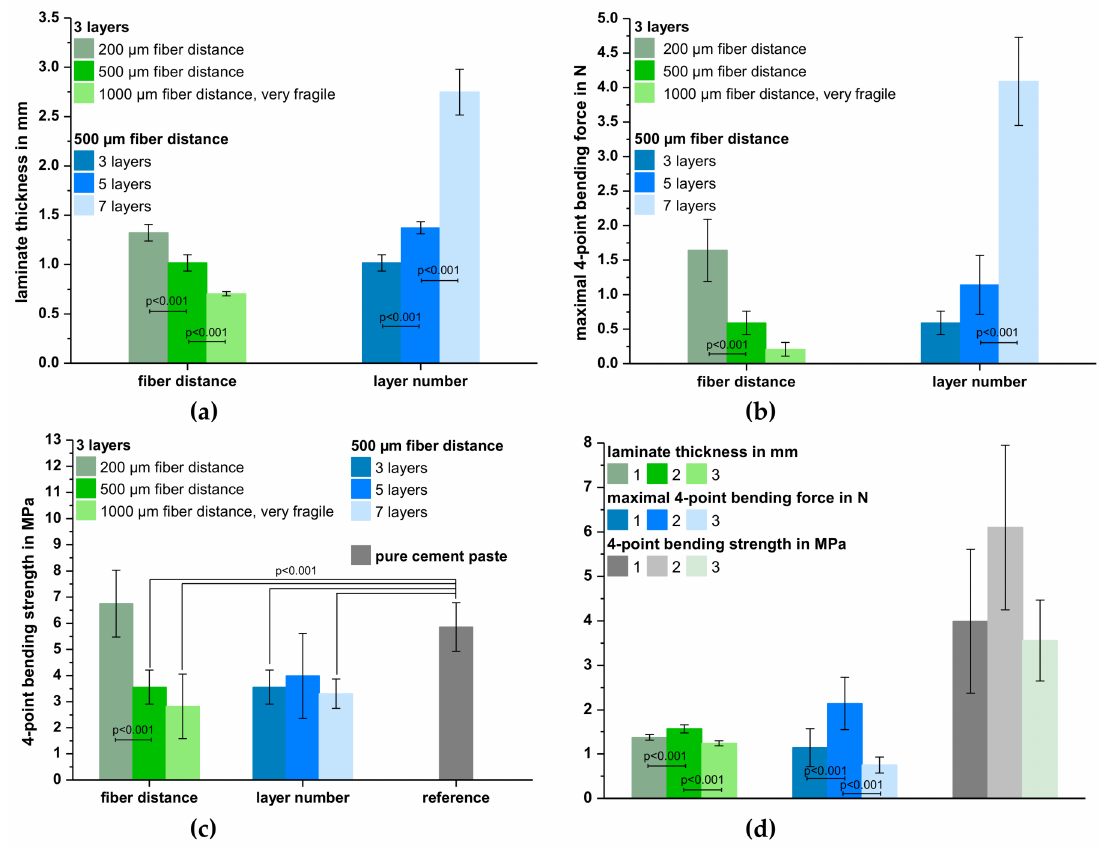
Figure 3. Laminate thickness ( a ), maximal 4-point bending force ( b ) and 4-point bending strength ( c ) of cured laminates from oil-based CPC paste and 3, 5 or 7 layers of MEW PCL scaffolds with a fiber distance of 200, 500 and 1000 µ m. Reproducibility regarding the preparation regime was analyzed with respect to laminate thickness, maximal bending force and bending strength using laminates of oil-based CPC paste and five layers of MEW PCL scaffolds with a fiber distance of 500 µ m as an example ( d ). The numbers describe the repetition of the experiment for preparing and analyzing laminates with the same composition and manufacturing